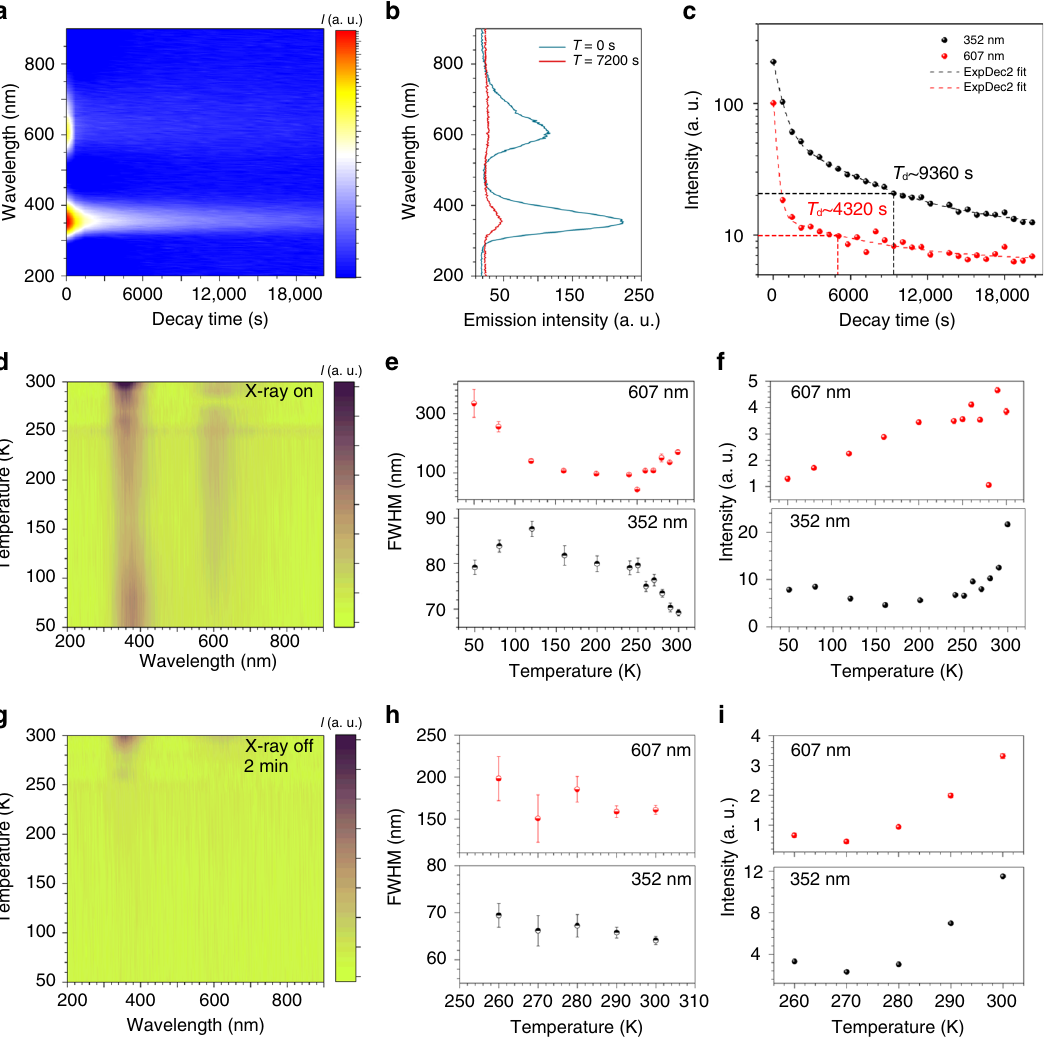
Fig. 2 X-ray excited ultralong phosphorescence in AlN SCs. a Time-dependent PL spectra of the AlN SC, showing an ultralong (>20,000 s) UV phosphorescence. b Steady-state PL spectra after turning off X-ray for 0 and 7200 s. c Decay curve of the UV and yellow phosphorescence, which are well fi tted to bi-exponential decay function. The calculated T d s of UV and yellow phosphorescence are 9360 and 4320 s, respectively. d Temperature- dependent PL spectra under X-ray excitation. e , f Extracted FWHM and intensities plotted with temperature, demonstrating that UV and yellow emission have thermal-related effect. g – i show similar temperature effect of the